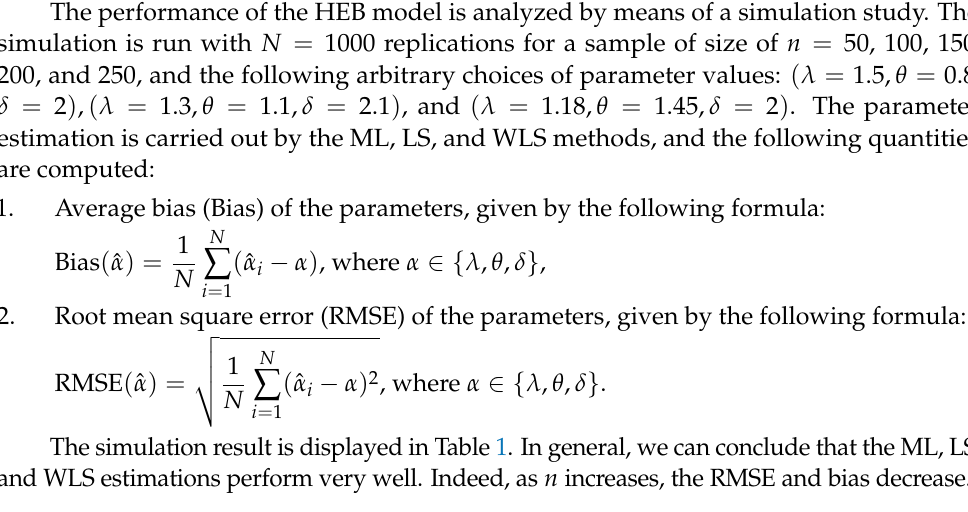
Table 1. Simulation